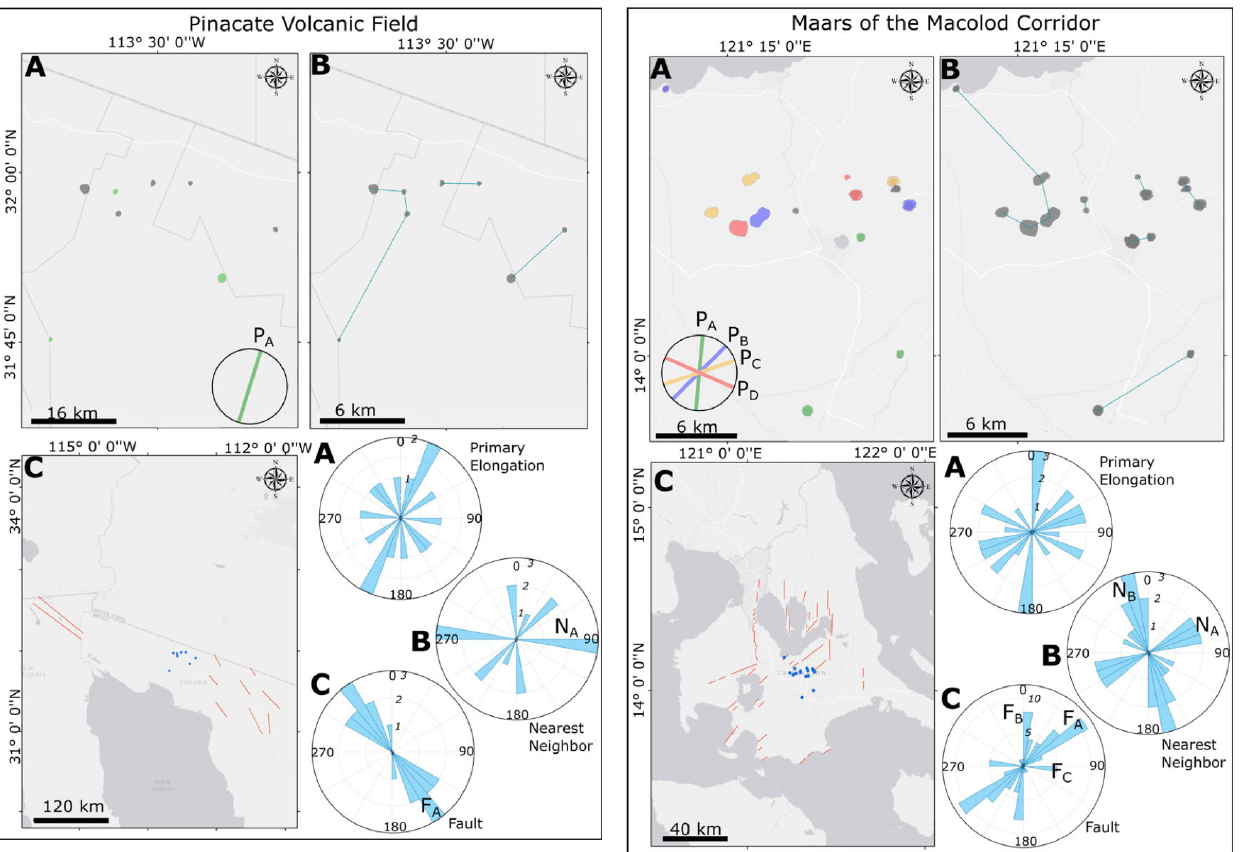
Figure 8: PinVF spatial (map) and orientation data (rose diagram). [A] Maars measured for primary elongation orientation. Color indicates modes Green (PA), Grey (none). [B] Nearest neighbor lines for maars. [C] Digi- tized maars (blue dots) and fault lines (red lines) from a regional view.